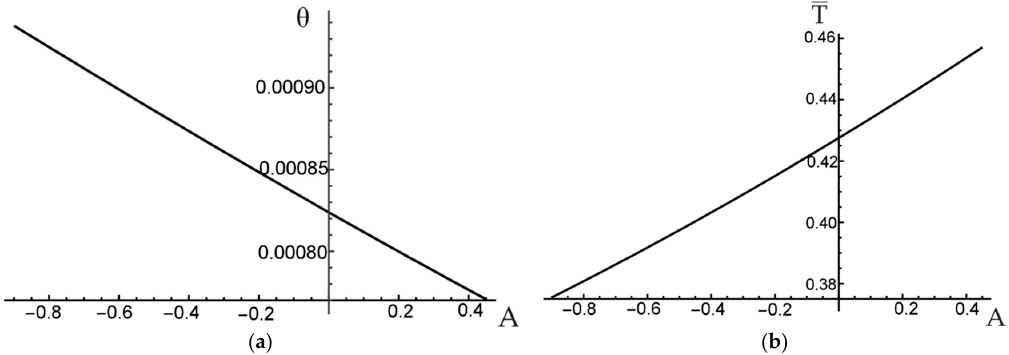
Figure 7. Influence of A on: ( a ) unit angle of twist; ( b ) external torque.